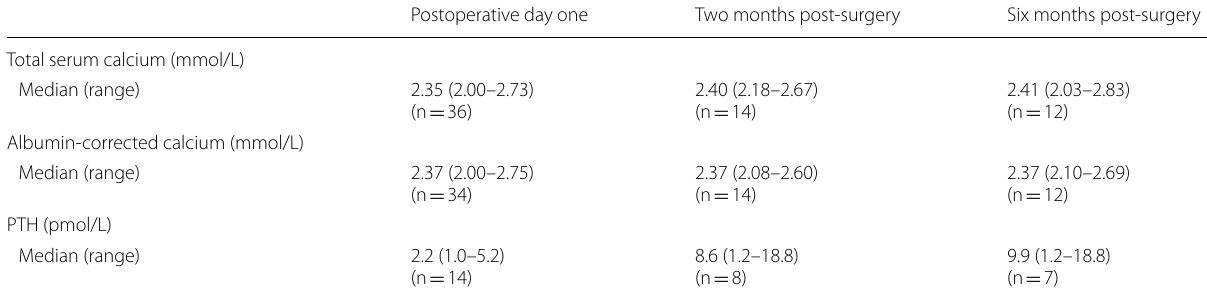
Table 5 Calcium and PTH levels